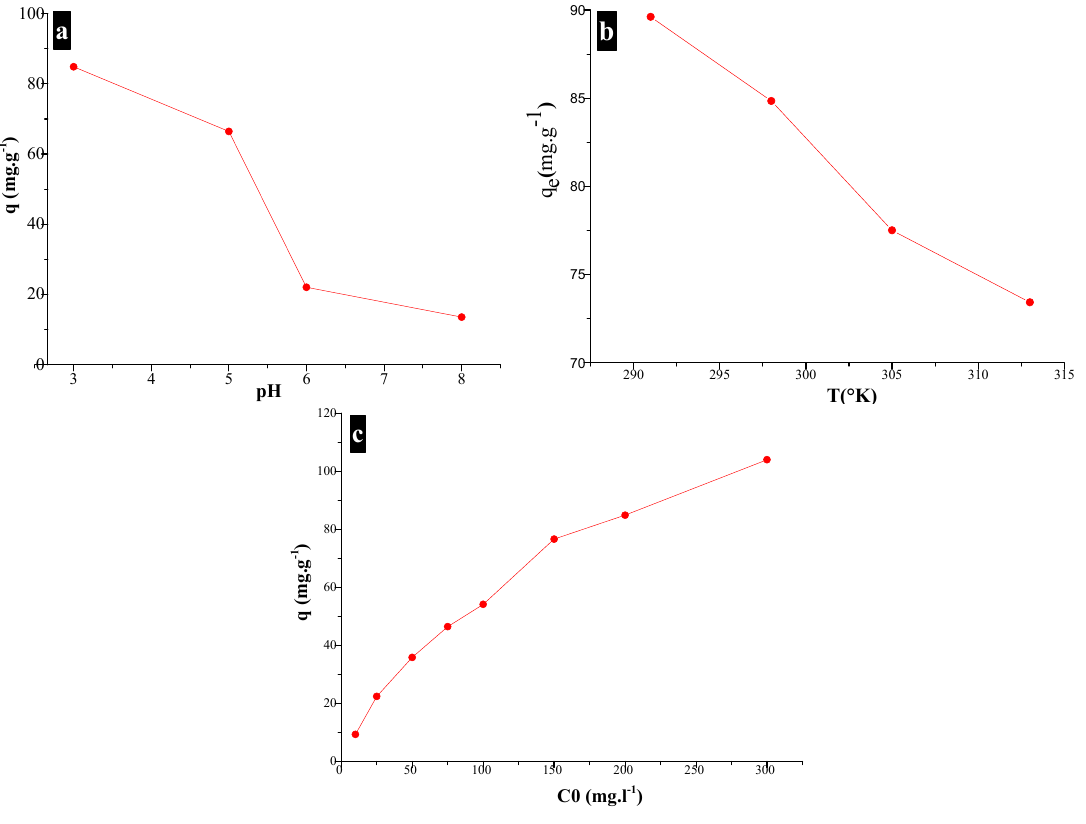
Figure 6. Influence of adsorption parameters on the adsorption capacity of PhR/NC-1: ( a ) effect of initial pH; ( b ) effect of temperature and ( c ) effect of initial concentration of ARS.